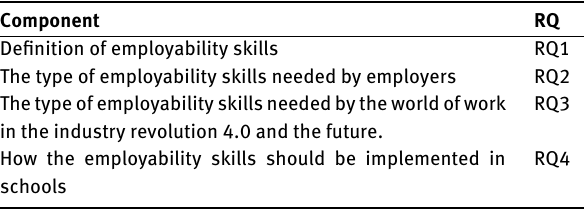
Table 1: Map of data extraction into research questions Component